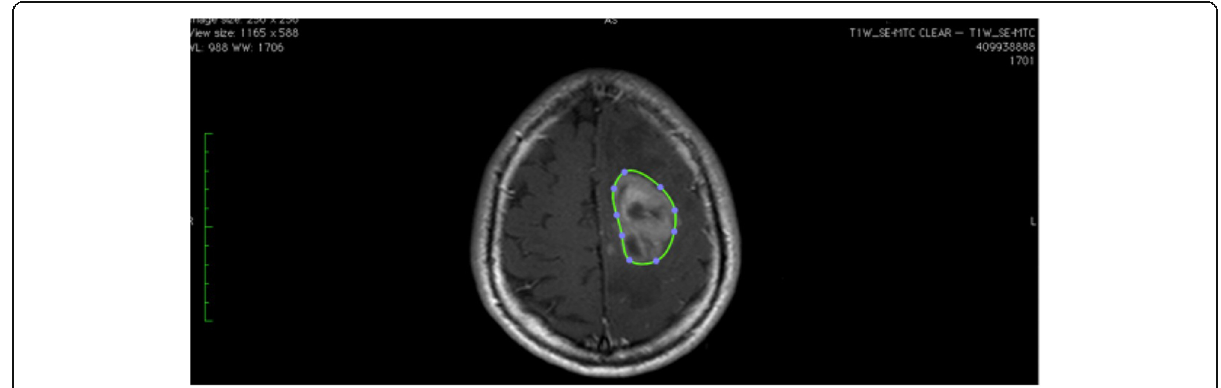
Fig. 1 Screen shot from Osirix software showing delineation of tumor region of interest (ROI) in an MRI slice